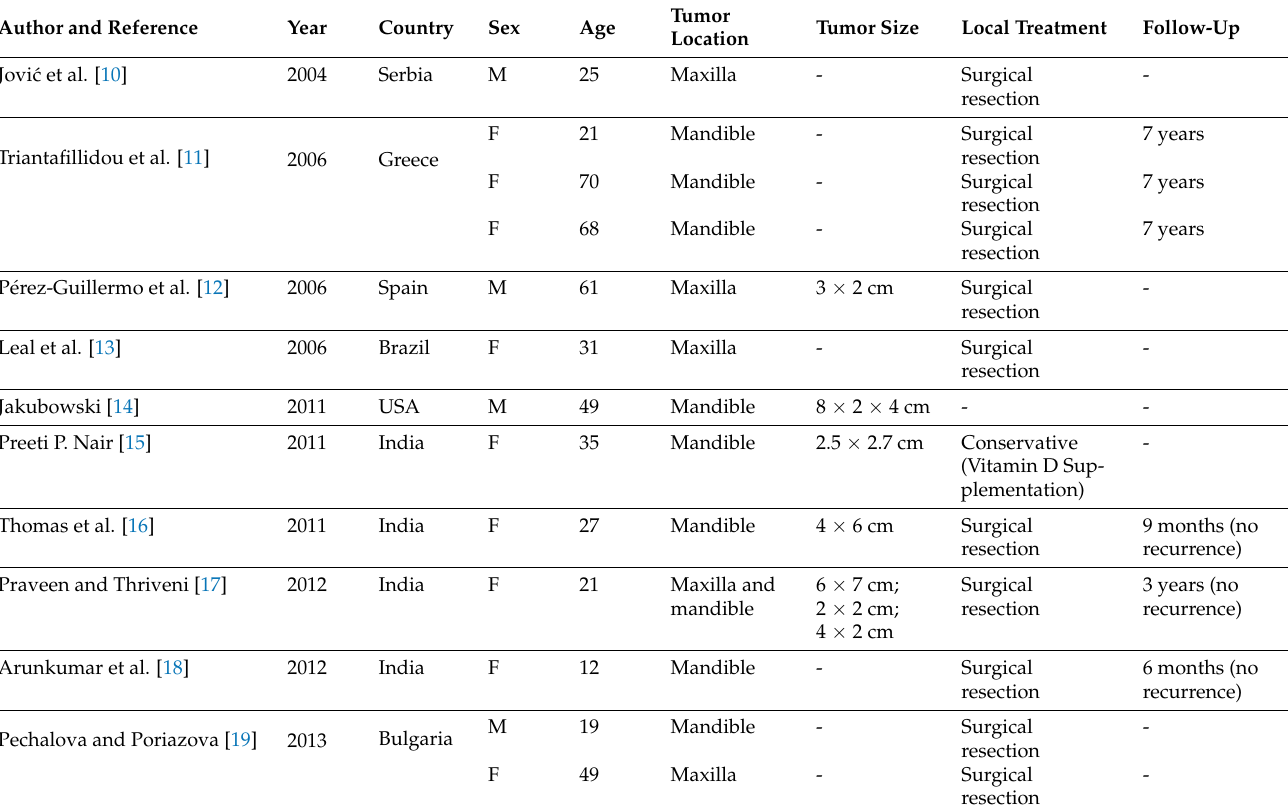
Table 2. Reported cases of brown tumor associated with secondary